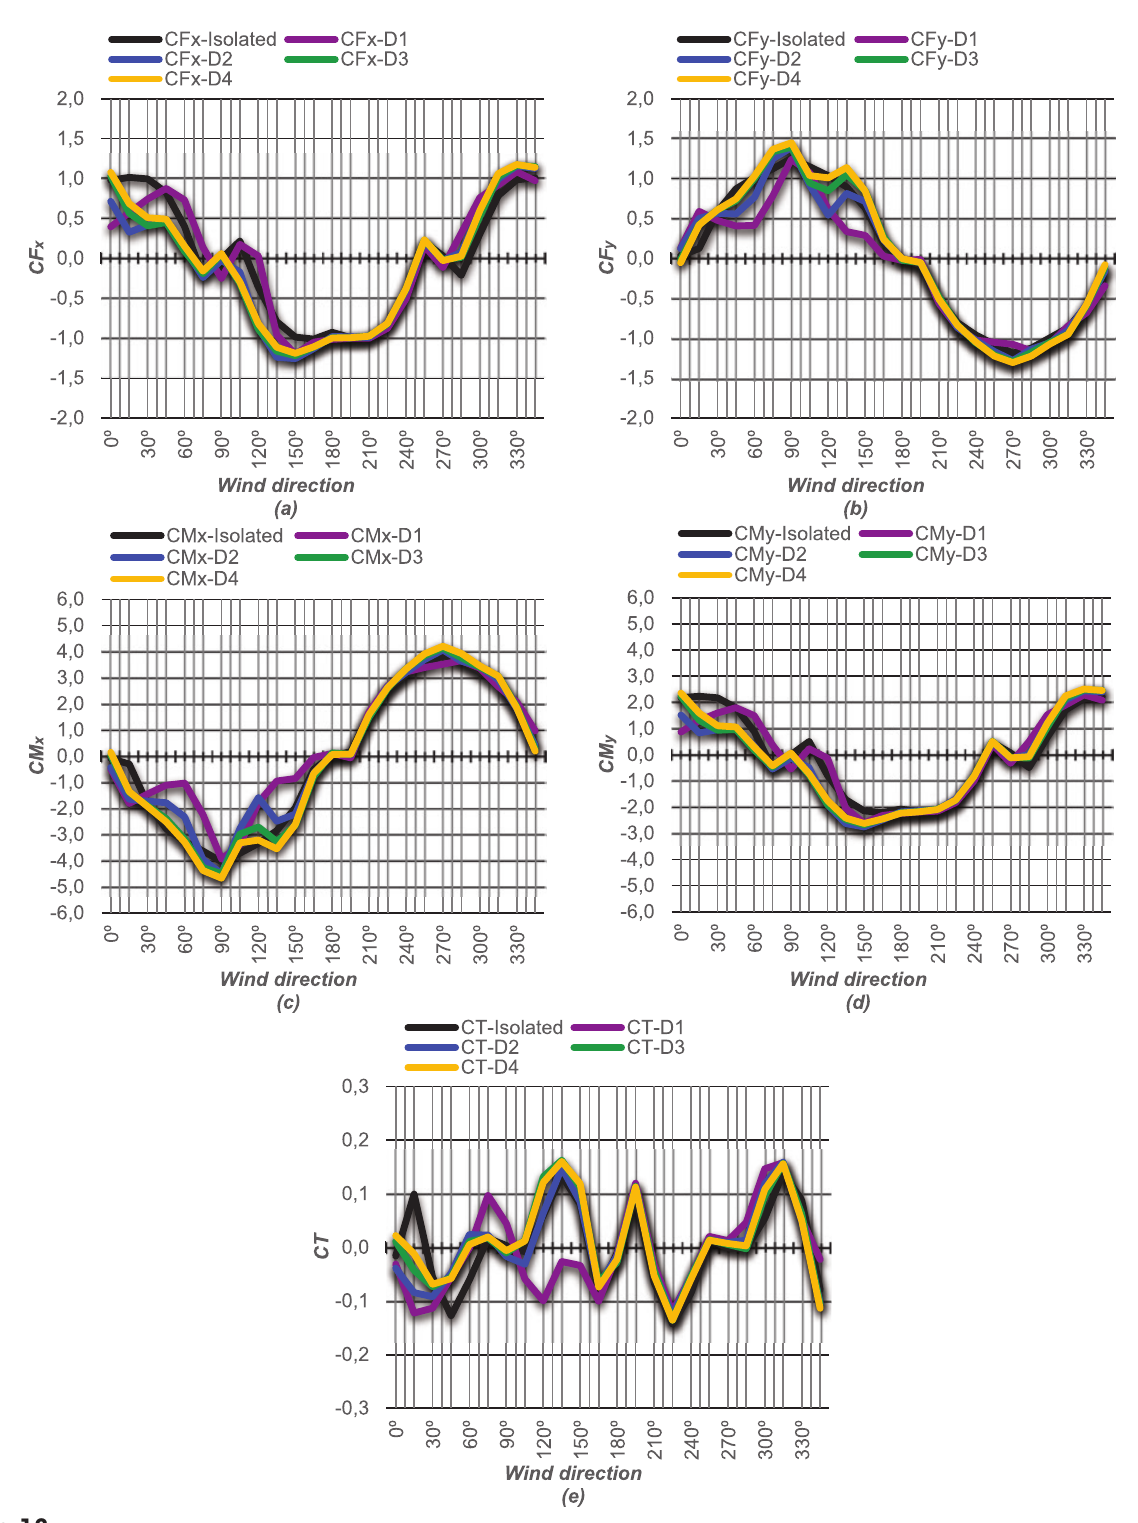
Load coefficients for the vicinity V6: (a) Resultant force in the direction of the X axis; (b) Resultant force in the direction of the Y axis; (c) Base momenta round axis X; (d) Base moment around axis Y; (e) Torsion around building